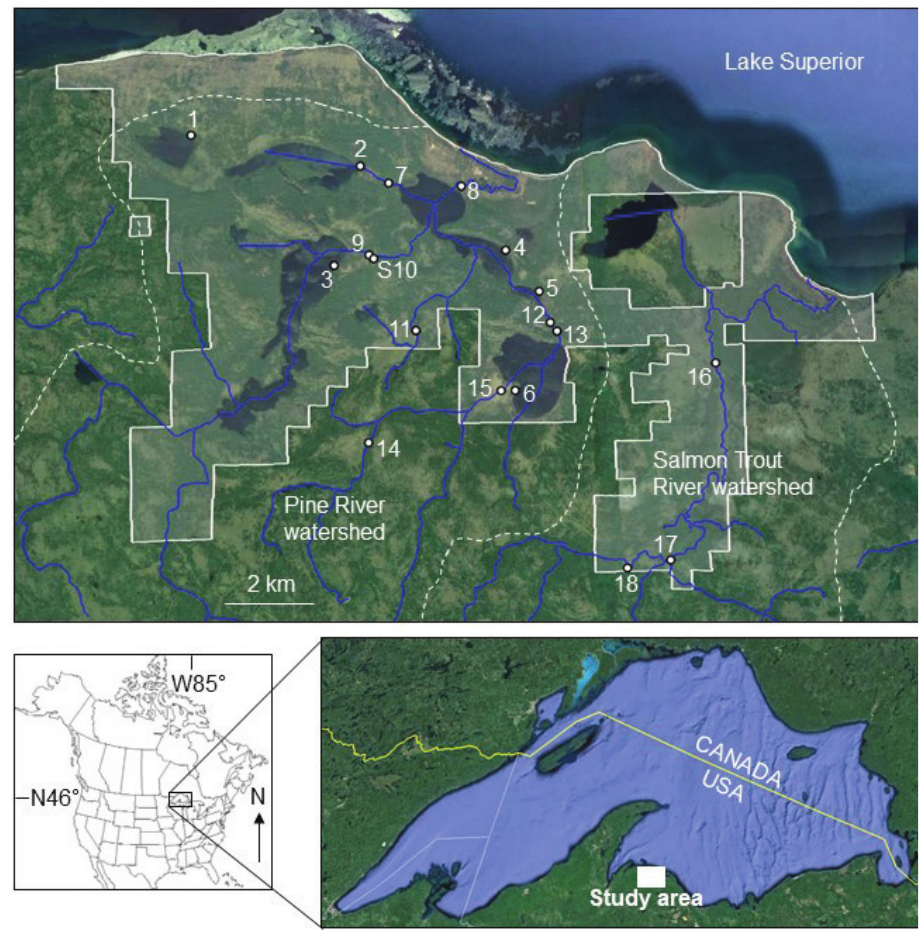
Figure 1. Location of the six lakes and 12 stream sites of the study. Solid white lines denote the ap- proximate borders of the Huron Mountain Club property. Dashed white lines denote the approximate boundaries of the Pine River and Salmon Trout River watersheds. Site numbers correspond to Tables 1, 2. Base maps Google, National Oceanic and Atmospheric Administration,